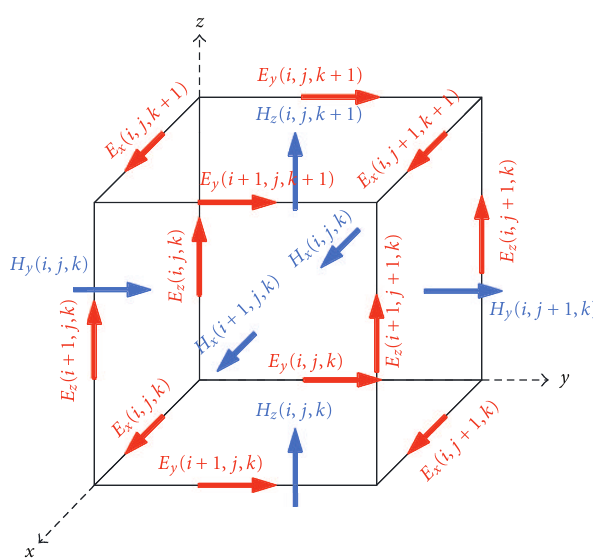
Figure 8: Single cell from the computational space used to compute Maxwell’s equations using FDTD